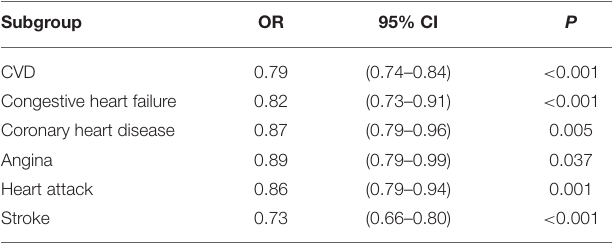
TABLE 3 | WQS regression model to assess the protective association of the mixture of 11 antioxidant micronutrients with individual CVDs and total CVD risk in adults from (NHANES) database,